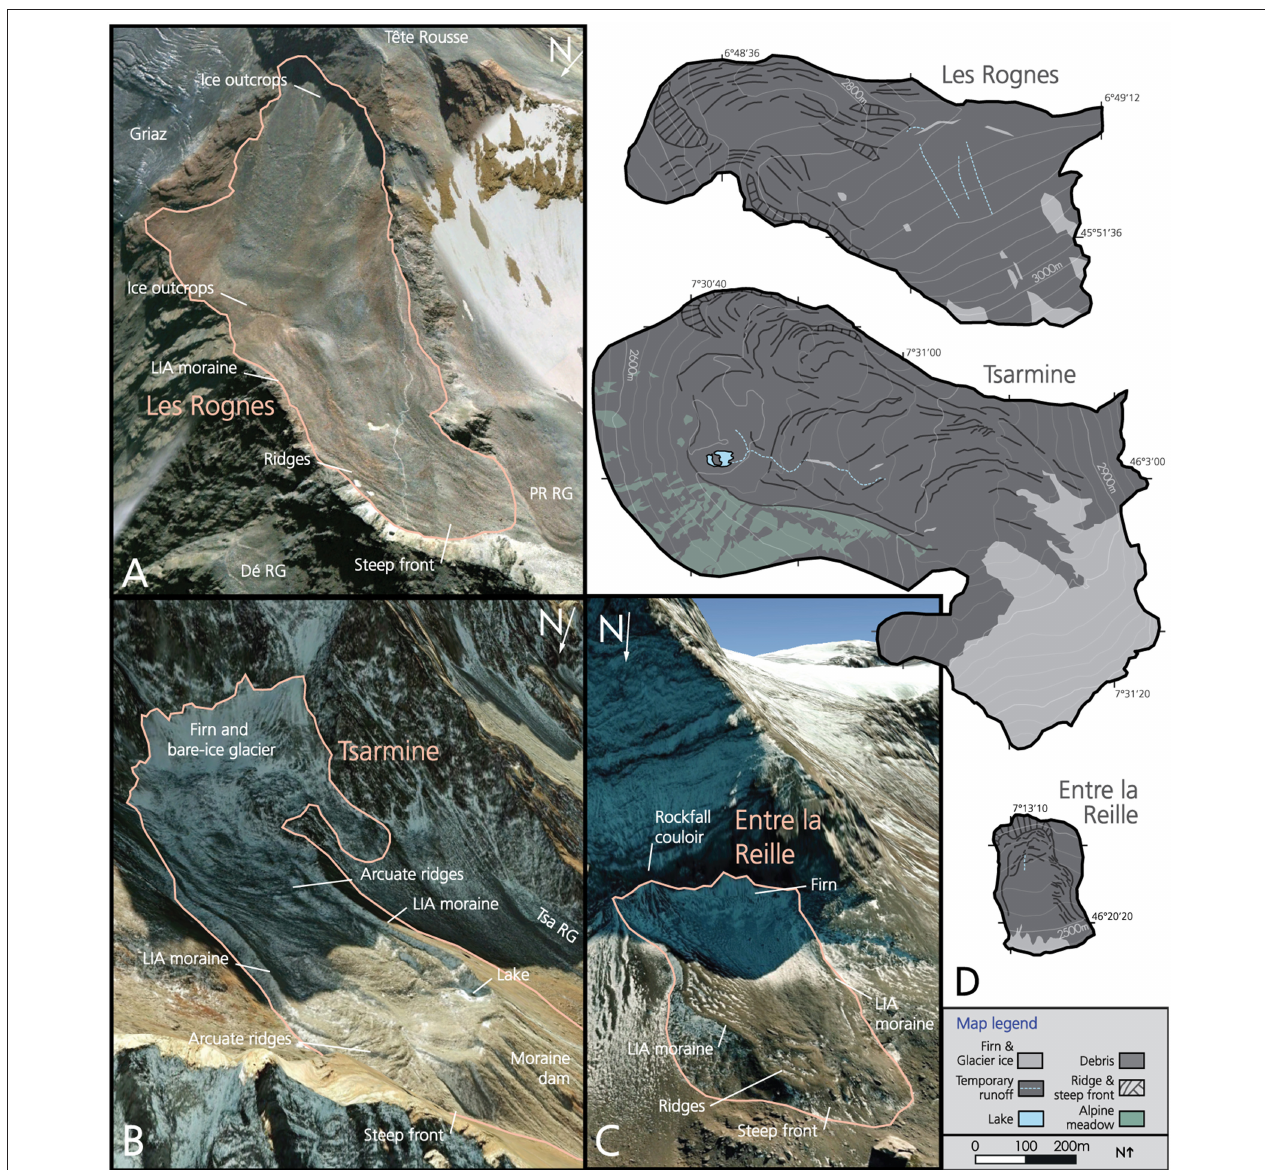
FIGURE 2 | 3D views of the study sites (A–C; © Google Earth 2015) and simplified maps (D). As the extension of glacier ice outcrops varies each year, its representation on map is an indication, derived from field observations and recent aerial images. RG refers to rock glacier in (A) and (B) .